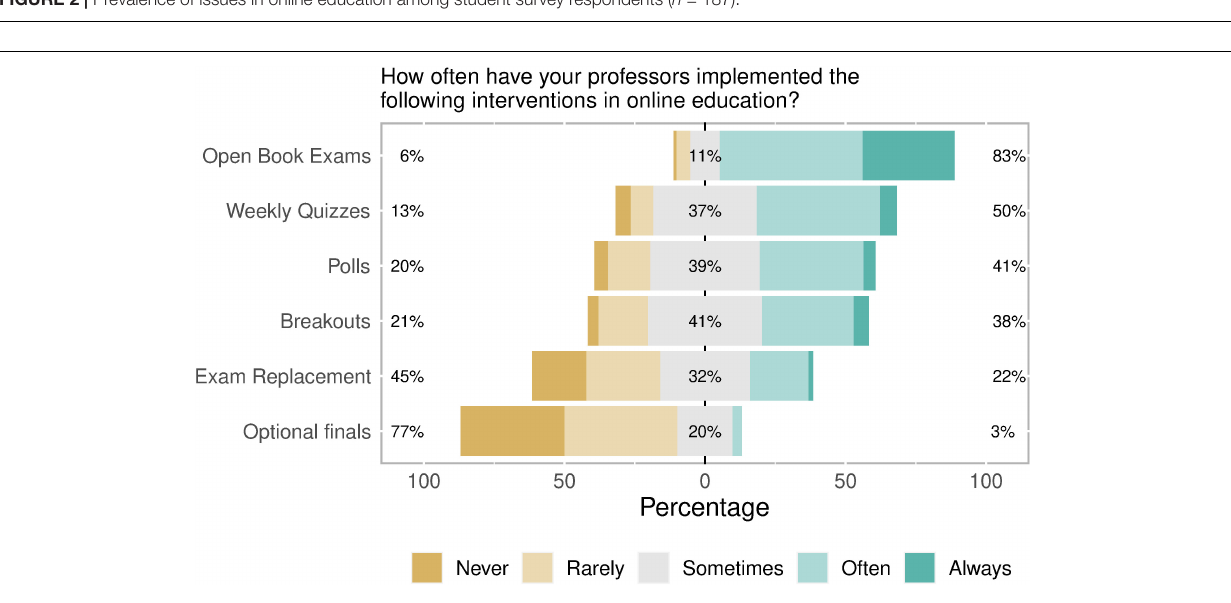
FIGURE 2 | Prevalence of issues in online education among student survey respondents ( n = 187).